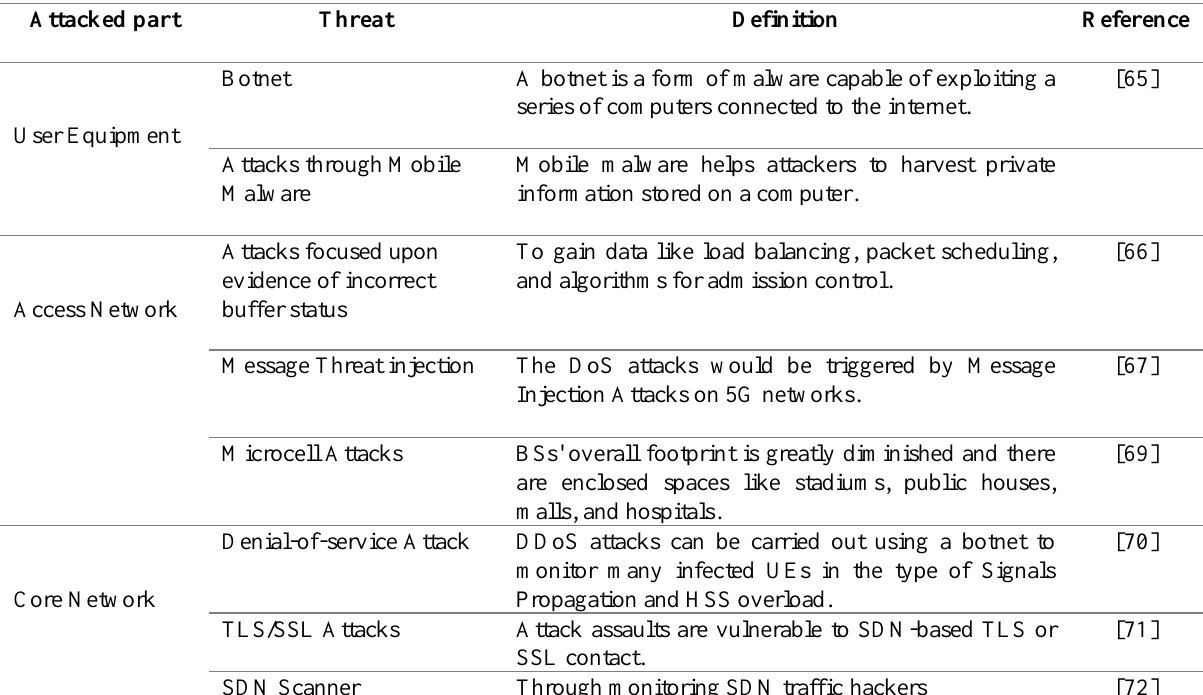
Table 1. Security concerns linked to 5G communication issues Attacked